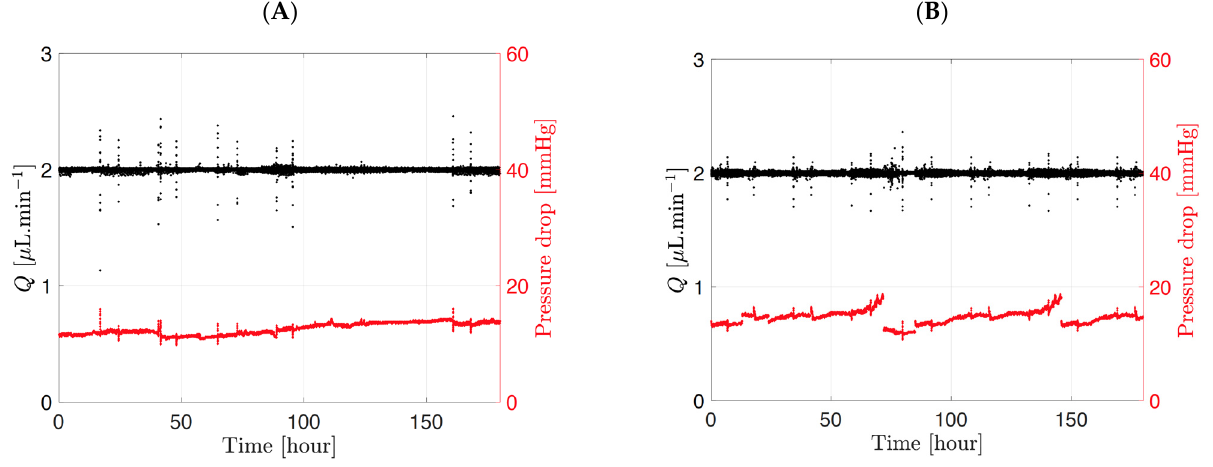
Figure 2. Typical flow rate and pressure graph for the ( A ) ciliary inflow model and ( B ) posterior inflow model in PBS, pH 7.4 using the microfluidic setup. The pressure ( red points ) adapts automatically to maintain a constant flow rate ( black points ) of 2.0 µL/min across the entire timeline.